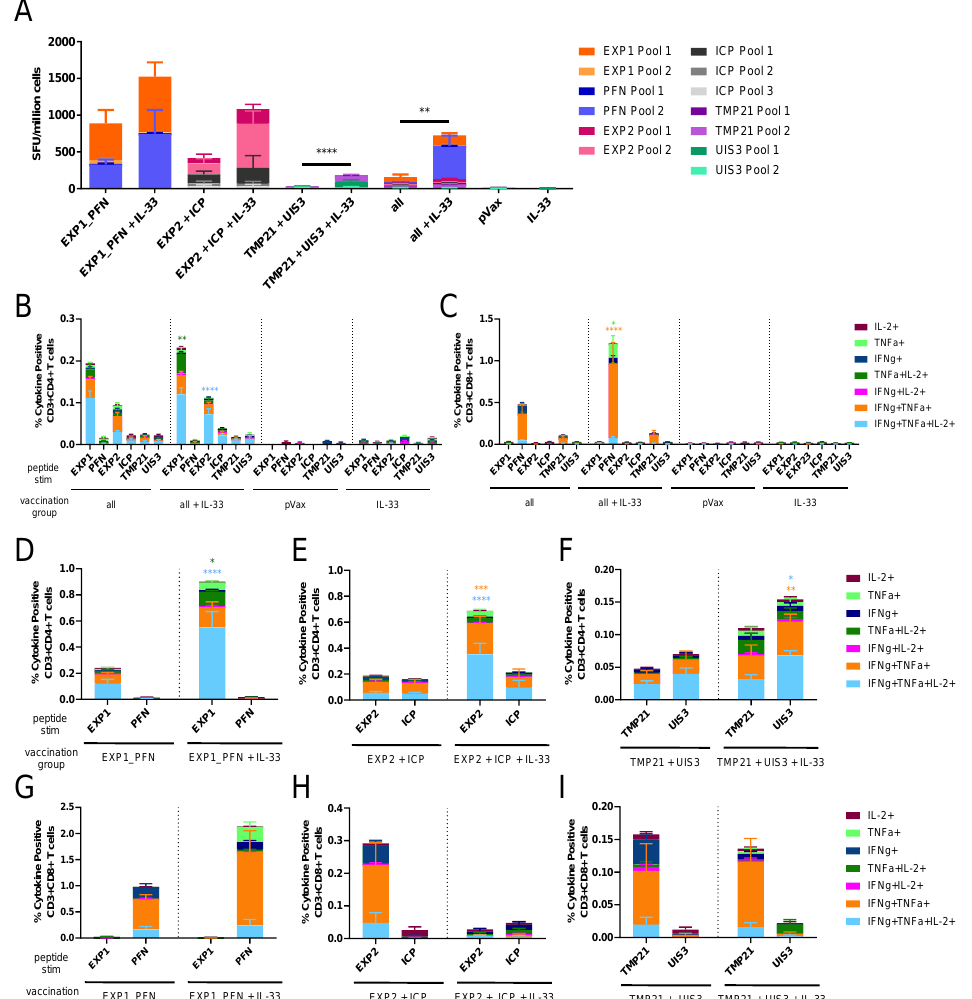
Figure 3. Functional profile of cellular immune responses elicited by co-formulated Py DNA vaccines in mice. Mice were immunized 4 times at 3-week intervals with the indicated co-formulation of vaccine constructs with and without plasmid IL-33. Splenocytes were collected 1 week after the final immunization. Immunization groups were: All vaccine constructs with or without IL-33, EXP1_PFN (exported protein 1_profilin) with or without IL-33, EXP2 (exported protein 2) and ICP (inhibitor of cysteine proteases) with or without IL-33, and TMP21 (transmembrane protein 21) and UIS3 (upregulated in infective sporozoites-3) with or without IL-33. ( A ) The Py antigen-specific cellular immune response induced by the indicated Py DNA vaccine co-formulation measured by IFN γ ELISPOT. Cells were stimulated for 18 h with peptide pools encompassing the entire protein. T-tests were used to compare groups with and without IL-33. ( B – I ) The Py antigen-specific cytokine production profile of CD4 + ( D – F ) and CD8 + ( G – I ) T cells induced by the indicated Py DNA vaccine co-formulation. Cells were stimulated with pooled peptides for 6 h, stained for intracellular production of IFN γ , TNF α , and IL-2, and then analyzed by flow cytometry. The bar graph shows subpopulations of mono-, double-, and triple-positive CD4 + and CD8 + T cells. Two-way ANOVAs with Tukey’s multiple comparison test were used to compare vaccine groups against the same group adjuvanted with IL-33. Asterix color represents the corresponding cytokine groups. * = p < 0.05, ** p < 0.01, *** = p < 0.001, and **** = p < 0.0001. Values represent the mean responses in each group ( n = 5) ± SEM.